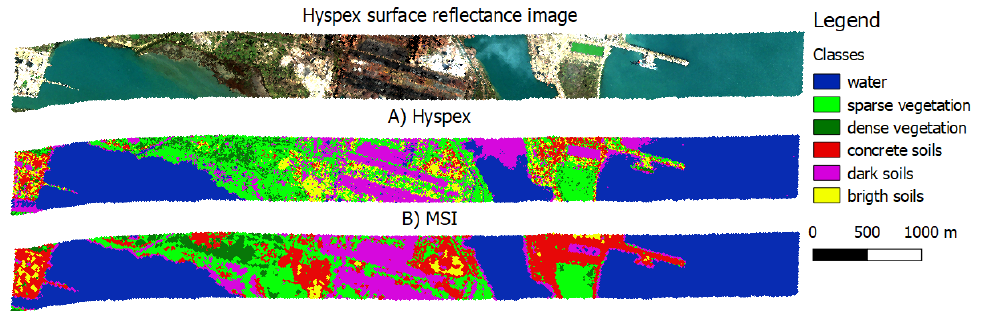
Figure 4. Snapshots of Surface reflectances obtained from radiances acquired by HYSPEX cam- era; ( A ) surface classification using HYSPEX image alone; and ( B ) surface classification using a combination of HYSPEX and MSI surface reflectances.